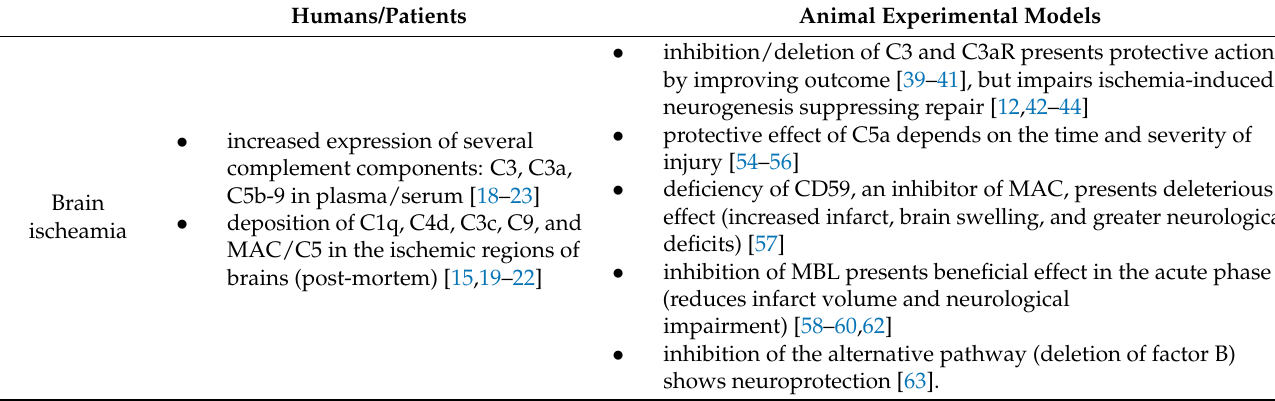
Table 1. The effects of dysregulated complement system in neurological disorders in humans and animal experimental models. Humans/Patients